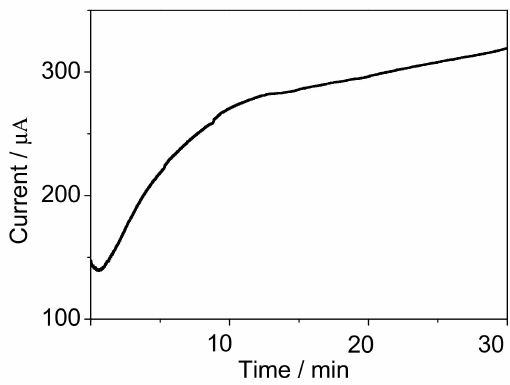
Figure 3. The chronoamperometry curve for electropolymerization of rGO-PPy at the potential of 0.8